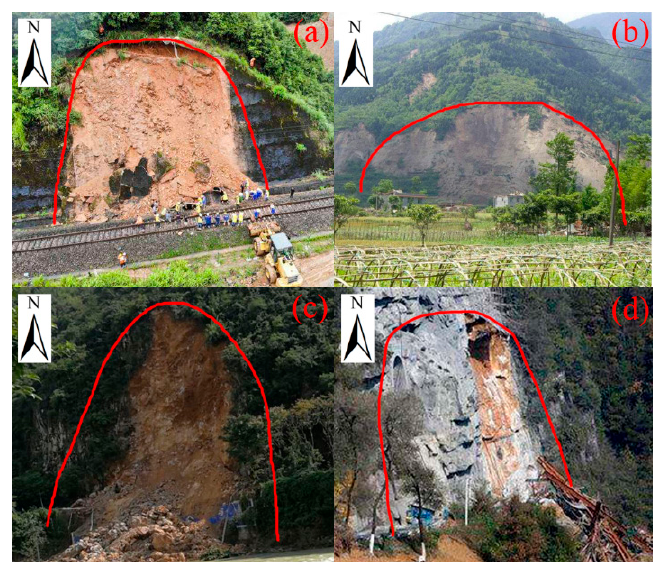
Figure 2. Photos of typical collapses in the study area: soil collapse ( a ), soil collapse ( b ), mixture collapse of soil and rocks ( c ), rock collapse ( d ).